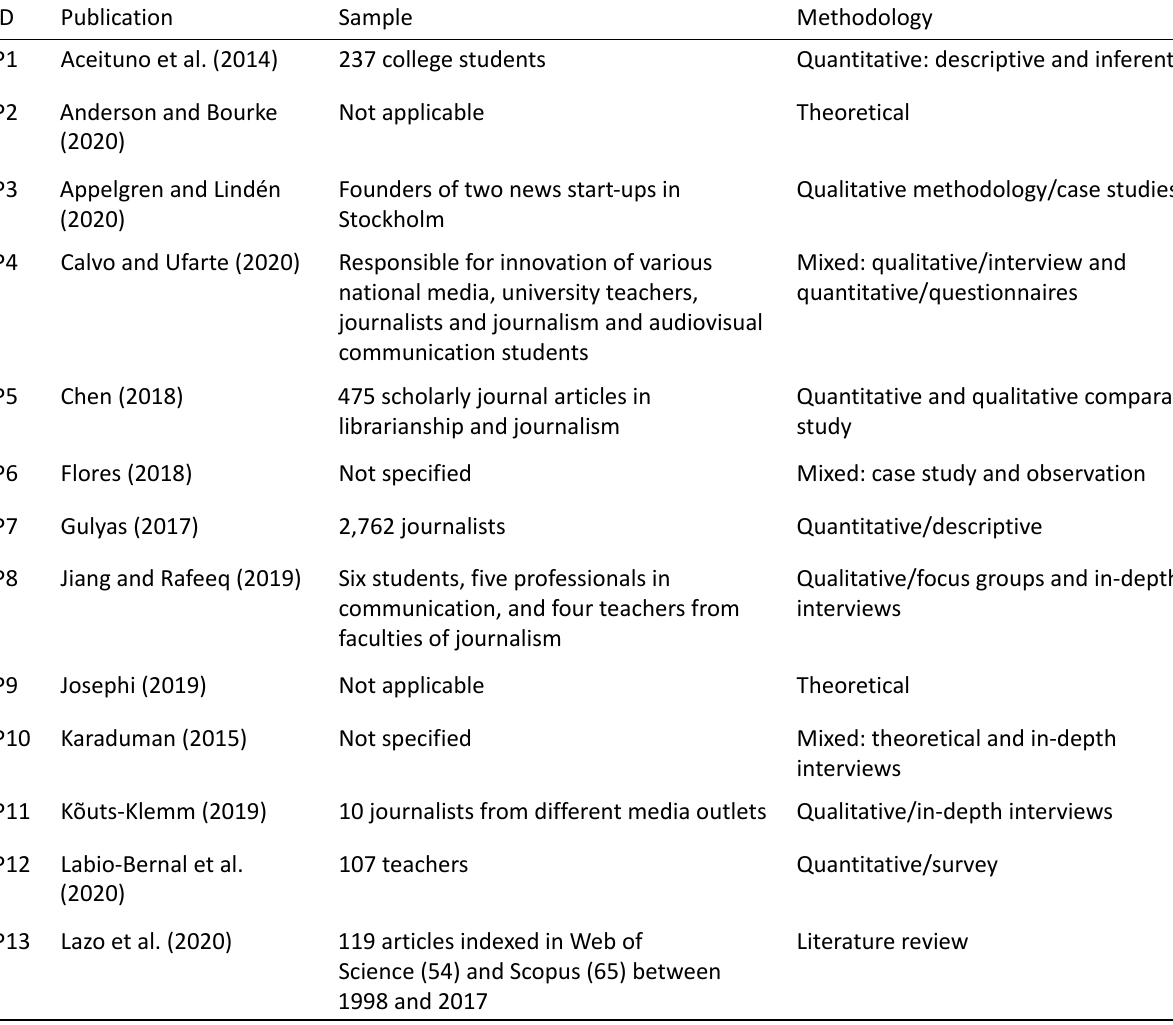
Table 2. Main characteristics of the publications included in the qualitative